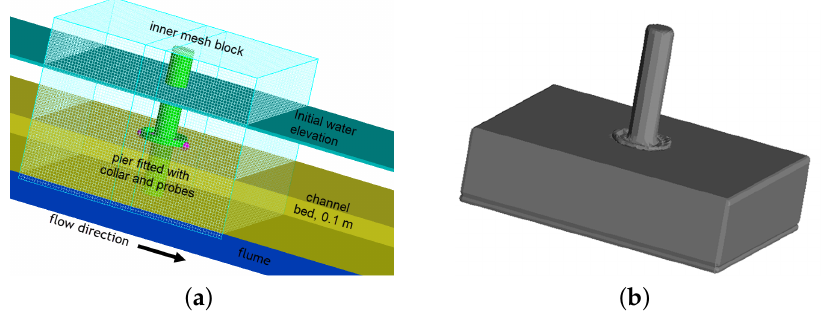
Figure 3. An example of ( a ) a bridge pier and the hooked-collar installation, as well as the inner mesh block and ( b ) favorized image showing the hooked-collar geometry.